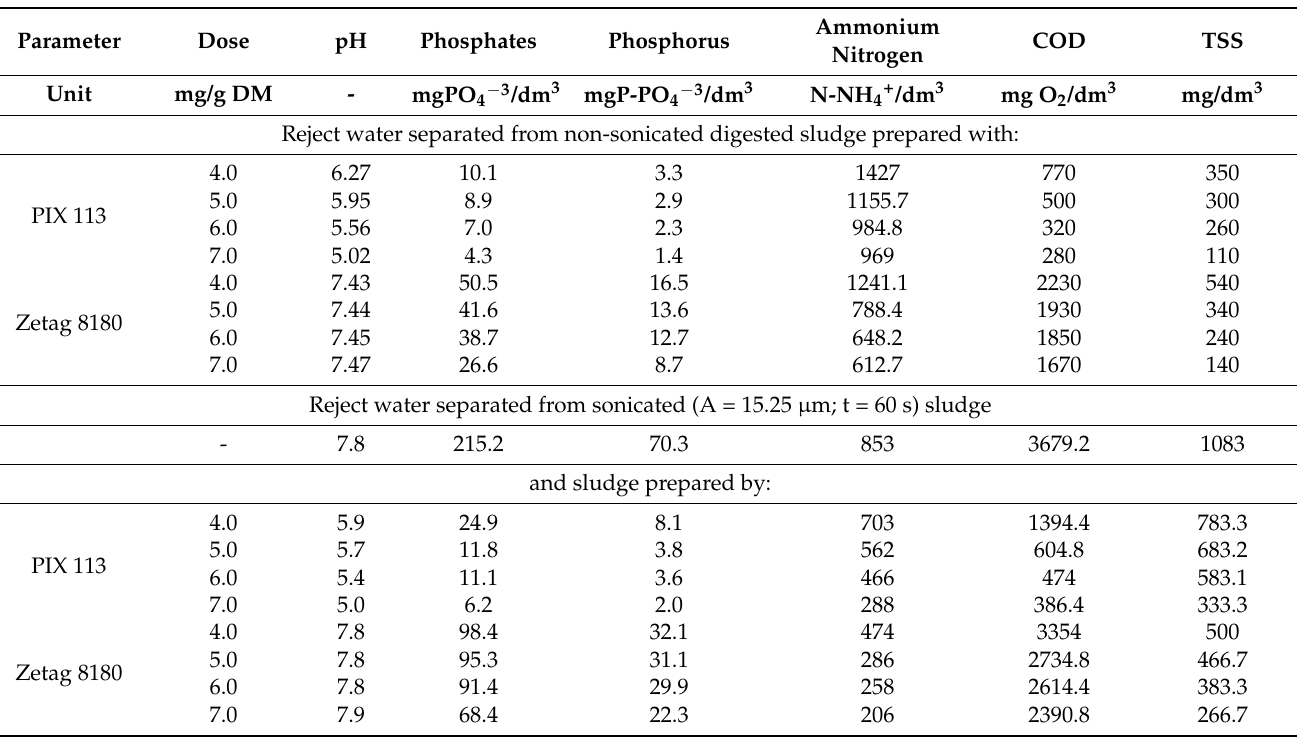
Table 4. Analysis of the reject water separated from prepared and non-prepared digested